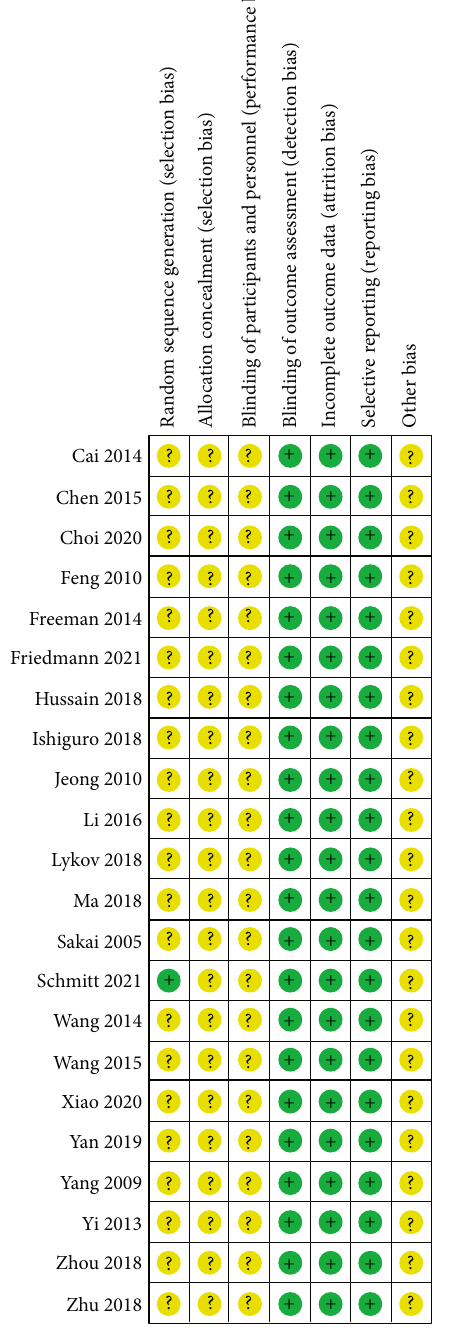
Figure 2: Risk of bias summary. +: low risk of bias; ?: bias